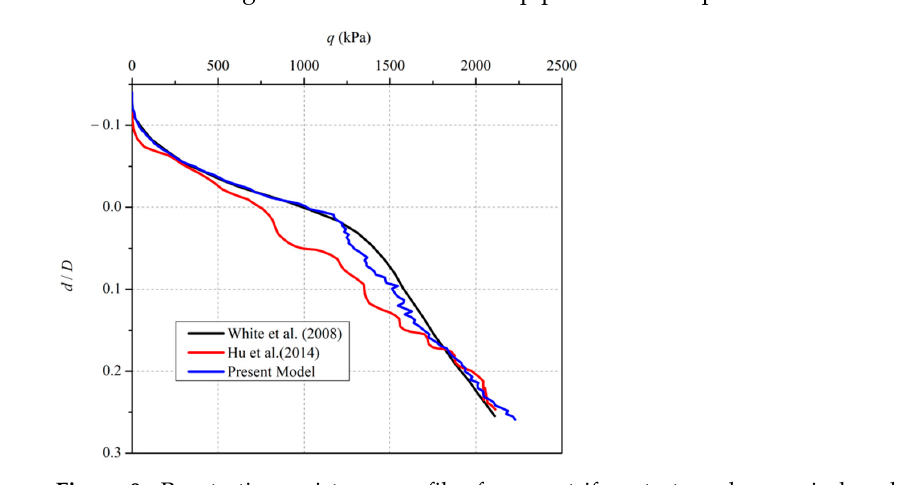
Figure 9. Penetration resistance profiles from centrifuge tests and numerical analyses (uniform sand)